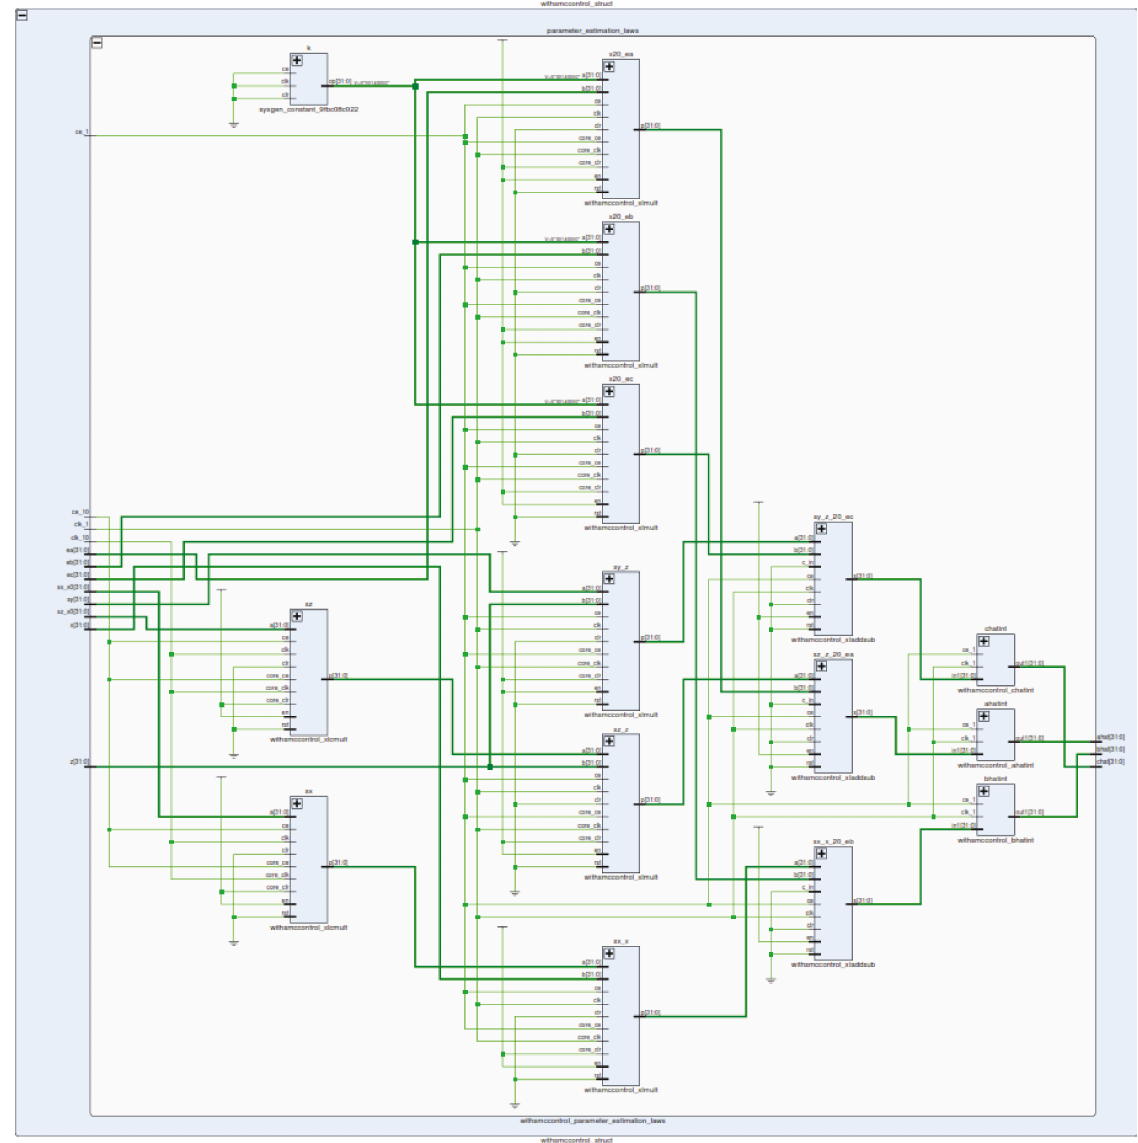
Figure 9: Xilinx RTL schematics of the controllers with sliding surfaces and parameter estimate